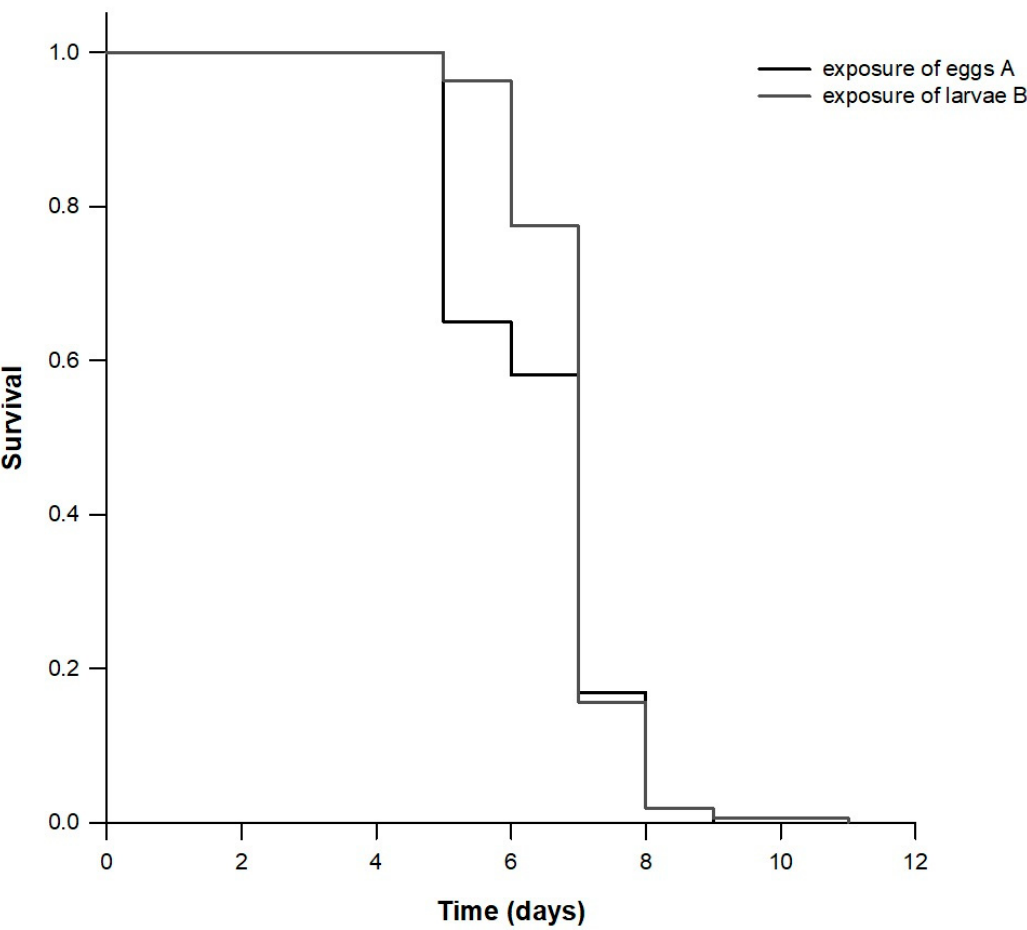
Figure 2. Magnification of survival curves of cohorts of Tribolium castaneum eggs and larvae exposed to concrete treated with chlorfenapyr. Different letters indicate that curves are statistically different. Table 1. Mean survival times and fecundity (95% C.I.) of Tribolium castaneum . Fecundity Survival Time 95% C.I. 95% C.I. Treatment (Days)